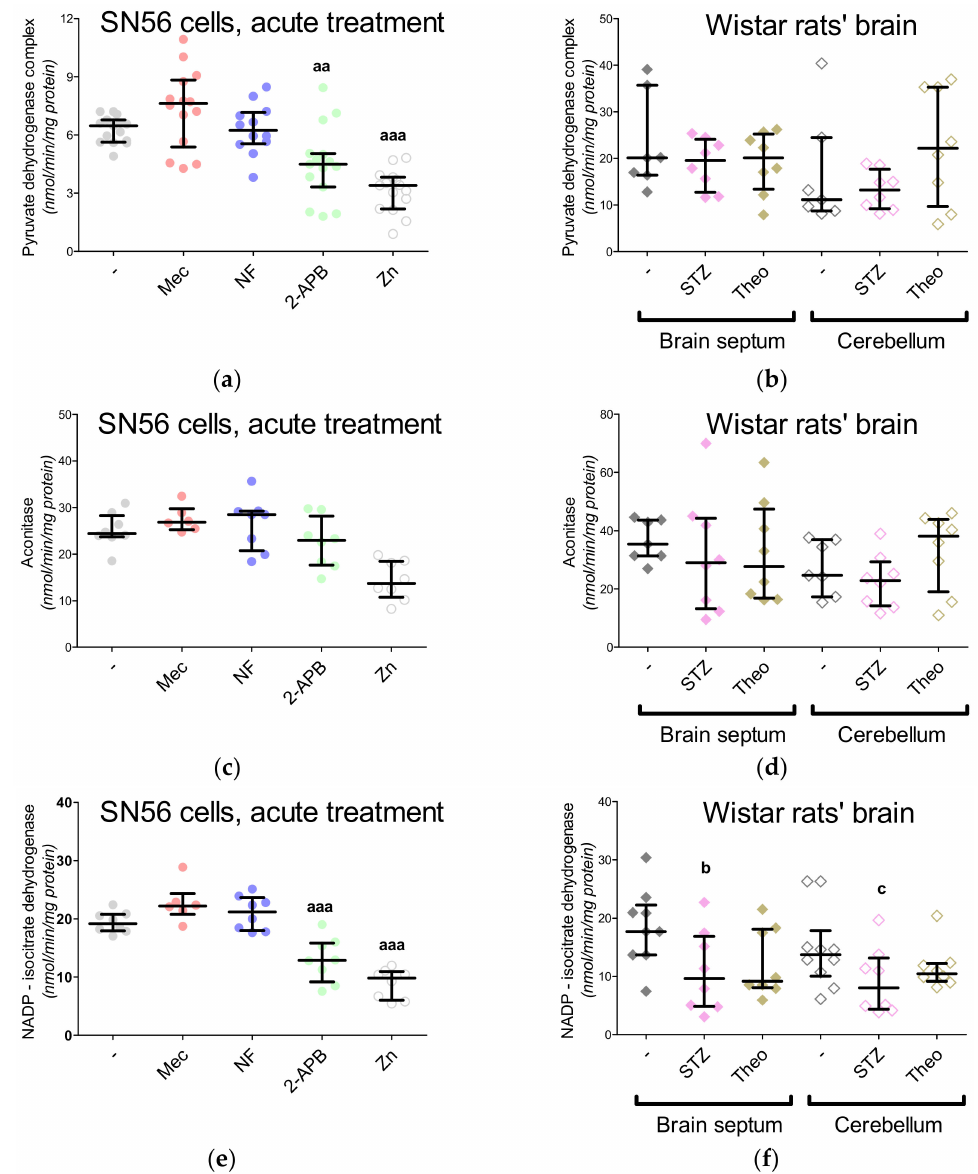
Figure 7. Enzymatic profile of SN56 cells ( a , c , e ) and Wistar rats’ brain tissues ( b , d , f ); ( a , b ) pyruvate dehydrogenase complex activity; ( c , d ) aconitase activity; ( e , f ) isocitrate dehydrogenase activity. Data are median (25th–75th percentile) from 6–15 observations. Significantly di ff erent from SN56 control ( aa — p < 0.01, aaa — p < 0.001) or Sham control brain septum ( b — p < 0.05) or Sham control cerebellum ( c — p < 0.05). Abbreviations: 2-APB—0.050 mM 2-aminoethoxydiphenyl borate; Mec—2 µ M mecamylamine; NF—0.01 mM nifedipine; STZ: streptozotocin; Theo: theophylline; Zn—zinc